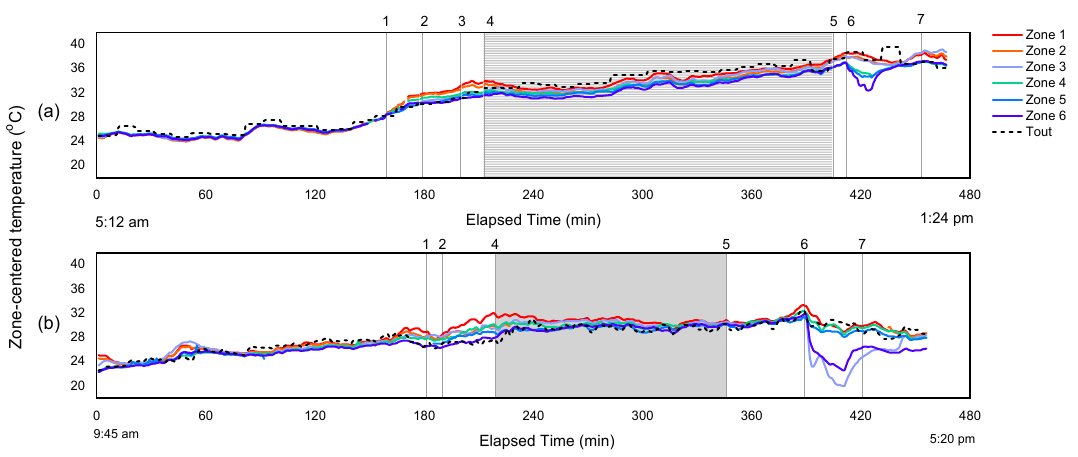
Figure 2. Ceiling-centered temperature profile representing 6 zones inside a pig trailer during: ( a ) a Very Hot morning trip; and ( b ) a Warm afternoon trip. Zones 1 to 3 represent trailer top deck, and Zones 4 to 6 represent bottom deck. Events occurred during the trip are numbered on the figure as follows (if present): 1. Arrival at a commercial pig barn; 2. Loading; 3. Misting applied inside trailer; 4. En route; 5. Arrival at abattoir; 6. Access to fans and misting during waiting; 7. Unloading.